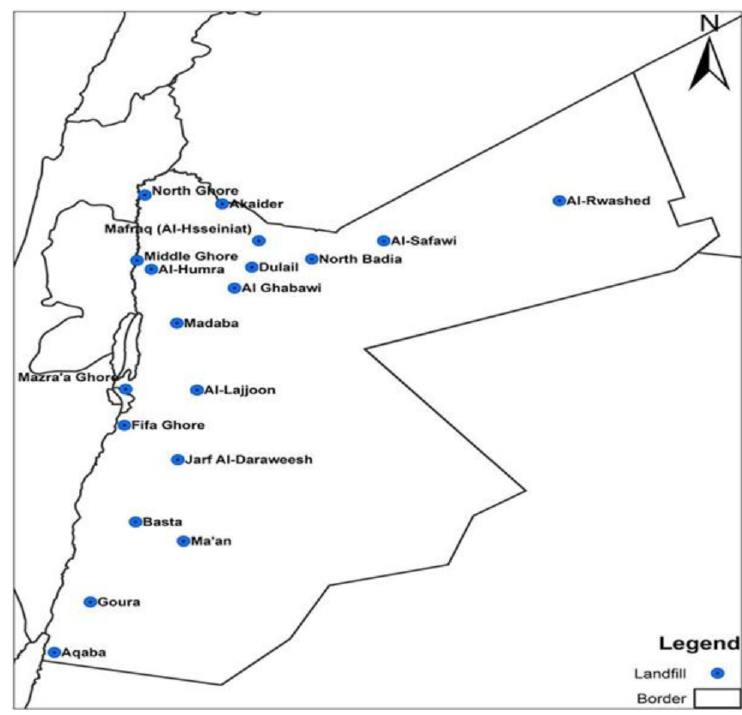
Figure 1. Operating landfills in Jordan (Developed by the